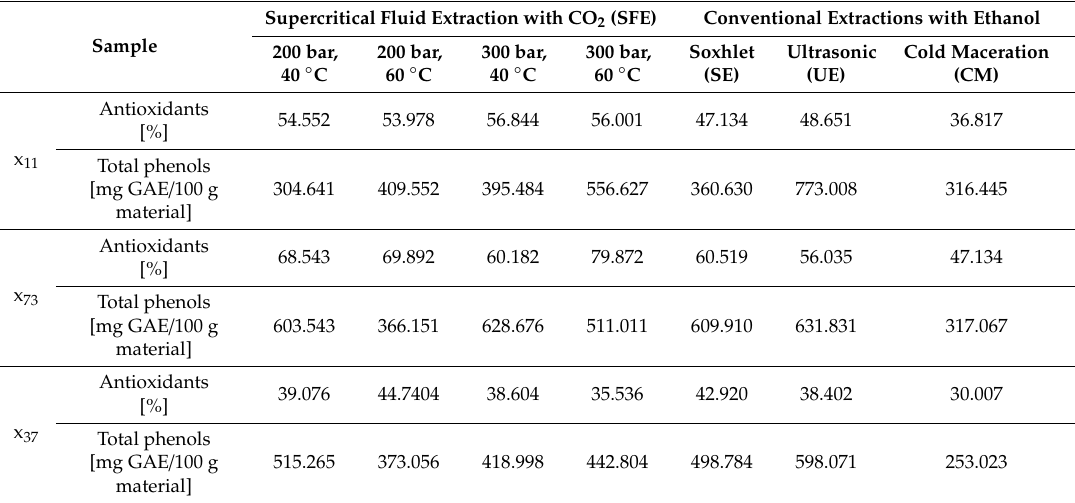
Table 2. Antioxidant activity values: A [%] and values of total phenols TP [mg GAE / 100g